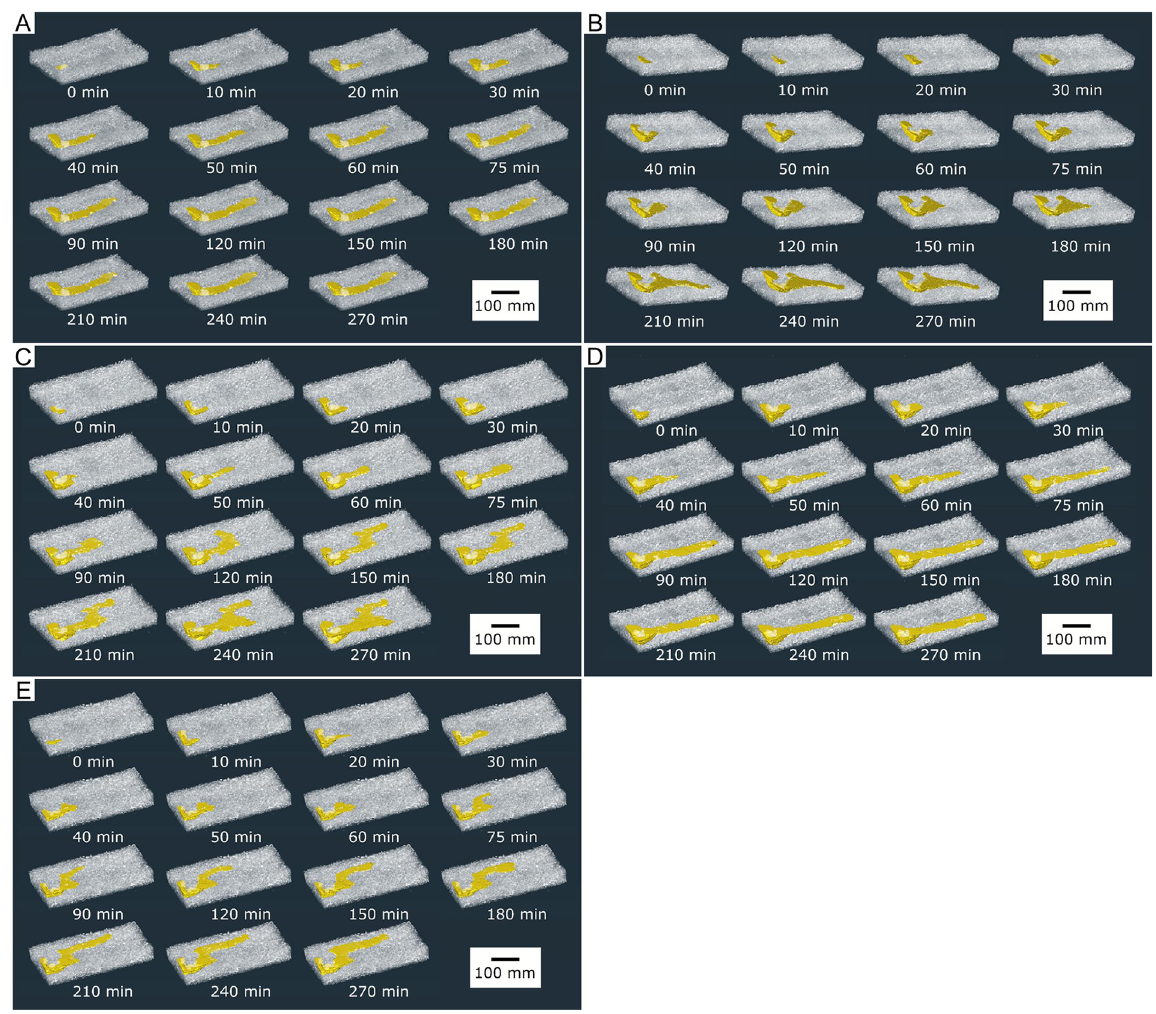
Fig 5. Changes in burrow morphology over time. Panels show the following: (A) Individual A, (B) Individual B, (C) Individual C, (D) Individual D, and (E) Individual